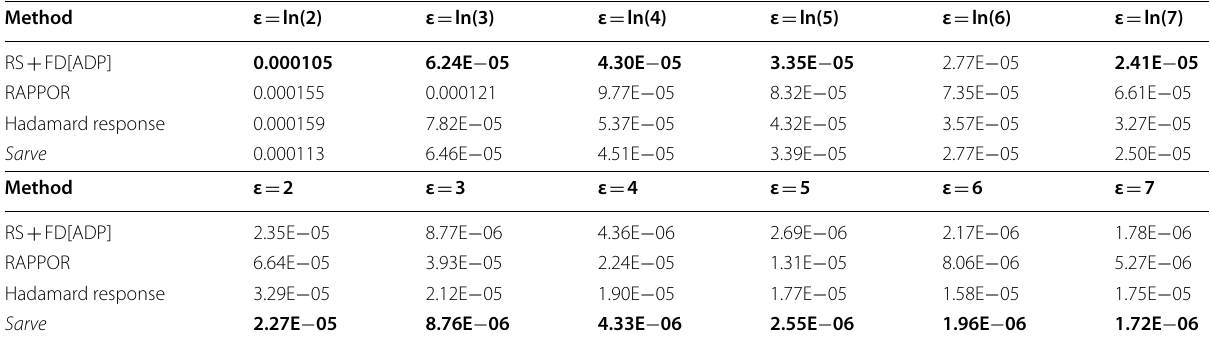
Table 7 The lowest MSE for the existing method and the enhancements, tested on synthetic 20-dimensional dataset having 50,000 records